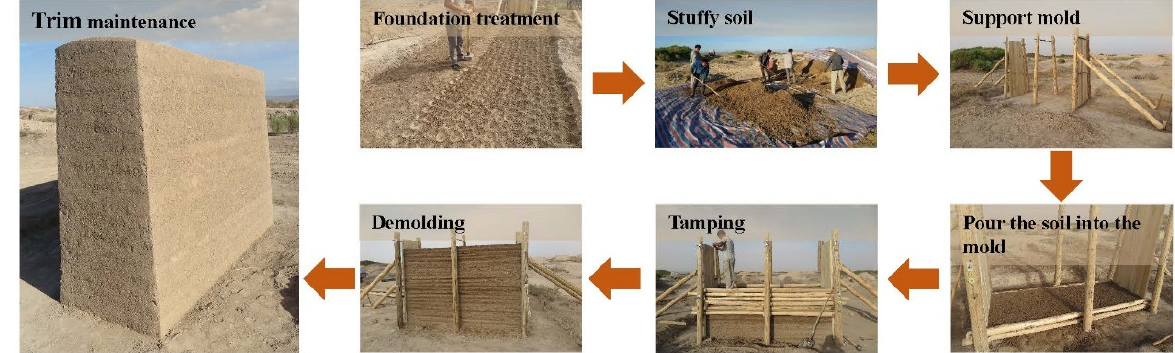
Figure 2. Testing wall tamping process.